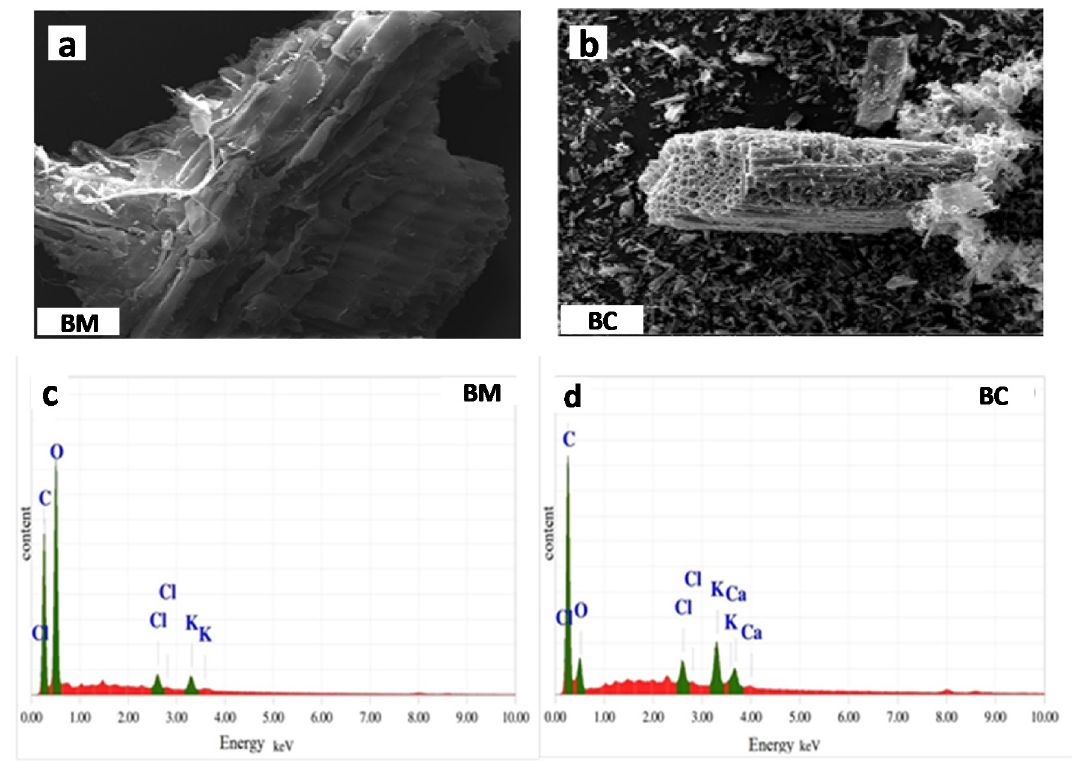
Figure 1. Scanning electron microscopy images of the ( a ) mesquite wood (BM) and ( b ) BM-derived biochar (BC), as well as energy-dispersive X-ray spectroscopy (EDS) analyses of ( c ) BM and ( d )